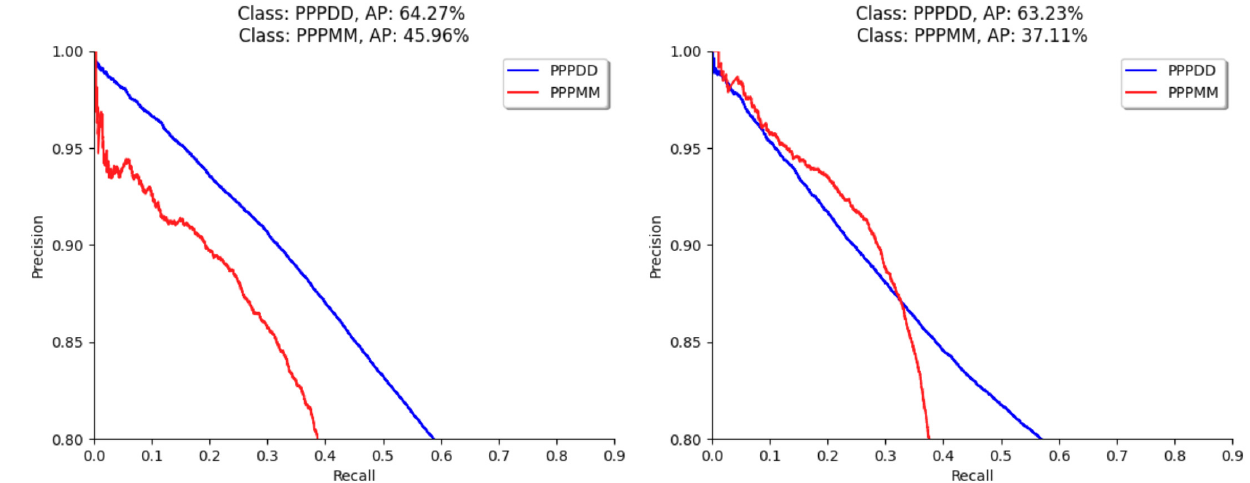
Figure 8. The Precision/Recall curve obtained from the results of the object detection models on the generated synthetic images. Left : EfficientDet, and Right : YOLOv5. In this Figure, PPPMM and PPPDD are monocot/dicot classes, respectively.